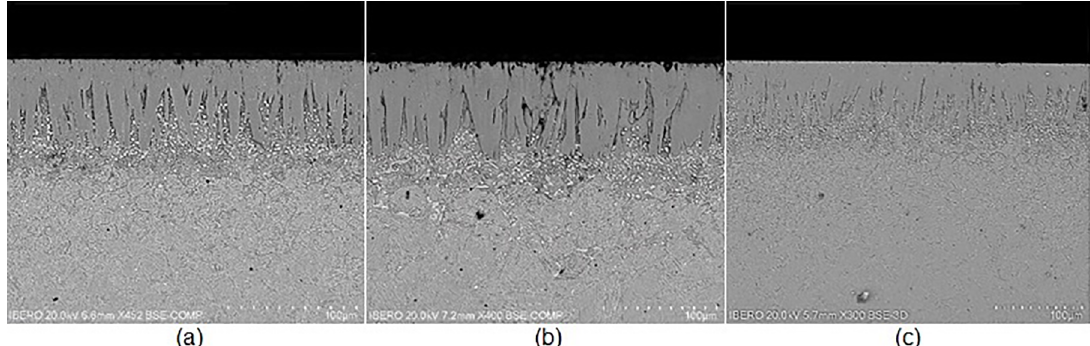
Figure 9. SEM micrographs of the boride layers formed at the surfaces of AISI S1 steel for three extra boriding conditions: (a) 1173 K for 3.5 h, (b) 1173 K for 6.5 h and (c) 1223 K for 1.5 h Table 4. Values of boron activation energies estimated from all diffusion models with the expressions used to estimate the Fe thickness. Activation D0 energy Q (m 2 s -1 ) (kJmol -1